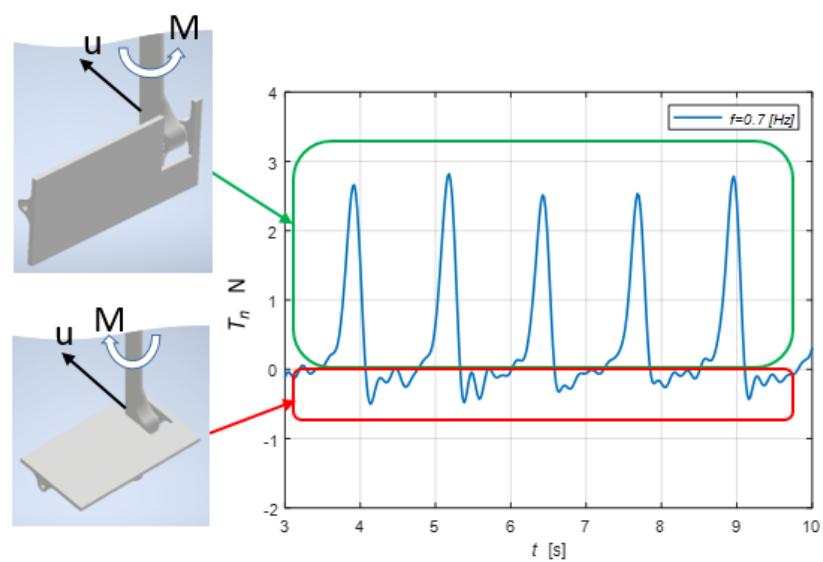
Figure 6. The net thrust as a function of time for an undulating frequency f = 0.7